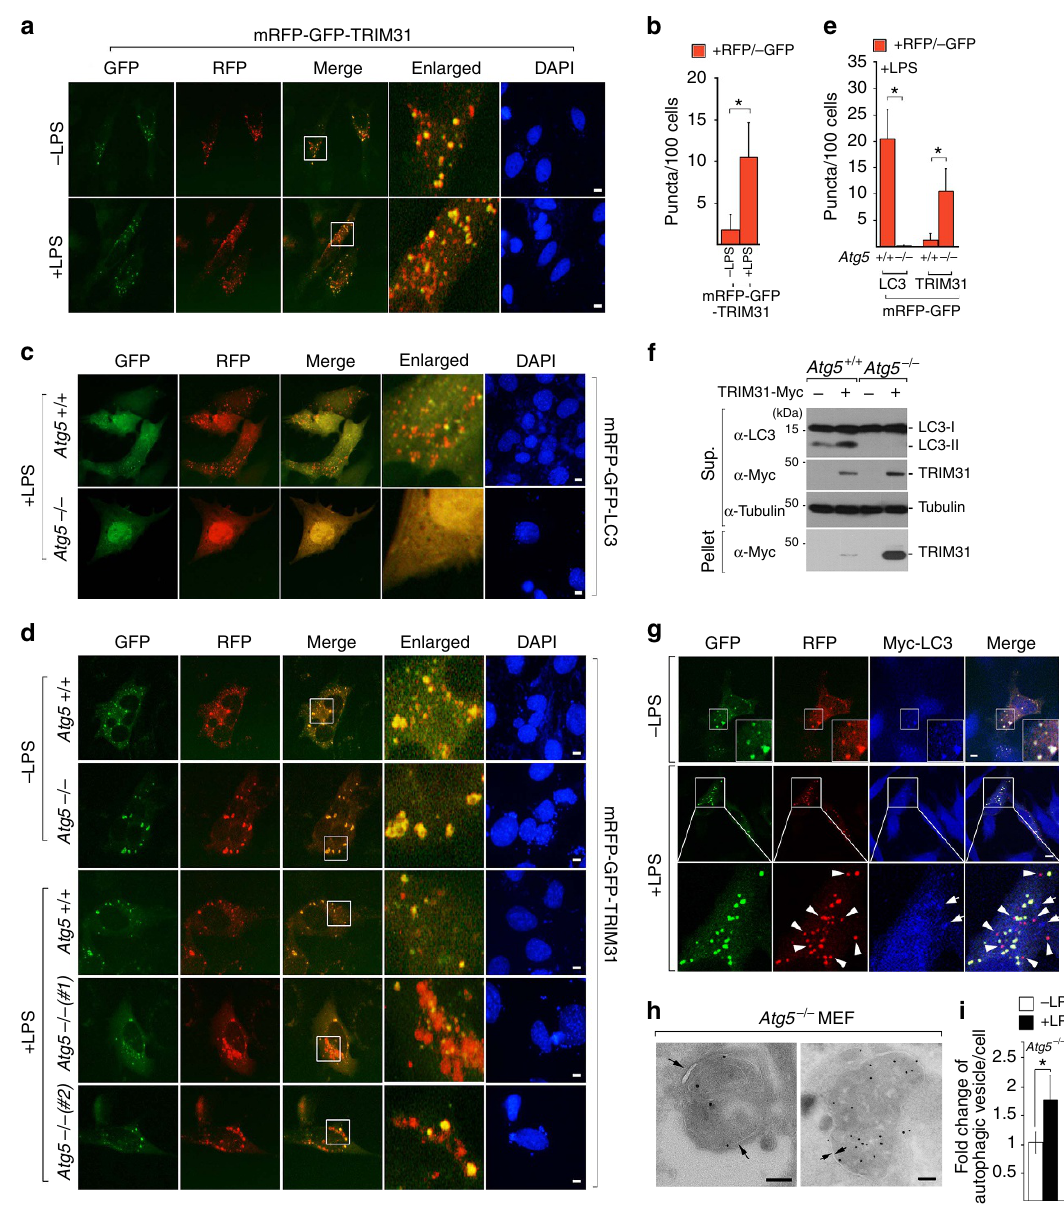
Figure 3 | TRIM31 induces LPS-induced Atg5/7-independent alternative autolysosome formation. ( a ) HeLa cells expressing mRFP-GFP-TRIM31 were left untreated or treated with LPS (100ngml (cid:2) 1 ) for 4h. Blue, DAPI. Scale bars, 5 m m. ( b ) Quantification of red puncta is shown in the graph. * P o 0.01 (Student’s t -test). ( c , d ) Wild-type or Atg5 (cid:2) / (cid:2) MEF cells were transfected with mRFP-GFP-LC3 or mRFP-GFP-TRIM31. After 24h, cells were stimulated with LPS (100ngml (cid:2) 1 ) for 10h and analysed by IFA. Blue, DAPI. Scale bars, 5 m m. ( e ) Quantification of red puncta is shown in the graph. * P o 0.01 (Student’s t -test). ( f ) Cell extracts from wild-type or Atg5 (cid:2) / (cid:2) cells expressing Mock or TRIM31-Myc were fractionated into pellets and supernatants by centrifugation. Detergent-insoluble pellets were resuspended in 1 (cid:3) SDS loading buffer and loaded onto SDS–PAGE gels with the same amount of supernatant, and then analysed by immunoblot analysis with the indicated antibodies. Tubulin was used as a loading control. ( g ) HeLa cells expressing mRFP-GFP-TRIM31 and Myc-LC3 (blue) were left untreated or treated with LPS (100ngml (cid:2) 1 ) for 4h. Scale bar, 5 m m. ( h ) RING deletion mutant of TRIM31 in Atg5 (cid:2) / (cid:2) MEFs is present on autophagosomal (left) and autolysosomal (right) structures. Atg5 (cid:2) / (cid:2) cells expressing TRIM31- D RING-Myc were stimulated with LPS (100ngml (cid:2) 1 ) for 3h with chloroquine (5 m M). The localization of TRIM31- D RING-Myc was examined by immunogold electron microscopy using anti-Myc antibody. Arrows indicate double-membrane structure. Scale bar, 0.1 m m. ( i ) Atg5 (cid:2) / (cid:2) cells expressing TRIM31- D RING-Myc were left untreated or treated with LPS (100ngml (cid:2) 1 ) for 3h. Quantification of autophagosomal vesicles is shown in the graph. * P o 0.01 (Student’s t -test). All data are representative of at least two independent experiments (mean ± s.d. in b , e and i residues on TRIM31 are involved in PE interaction, we distributed throughout the nucleus or cytoplasm and failed to constructed two truncation mutants, TRIM31-110G and detect any punctate structures in a similar pattern as TRIM31-163G, in which the glycine residues were made TRIM31 D BB (Supplementary Fig. 6c), suggesting that the available for covalent coupling with PE (Supplementary TRIM31–PE interaction is not mediated by glycine-dependent Fig. 6b). Our examination revealed that these mutants were covalent binding.